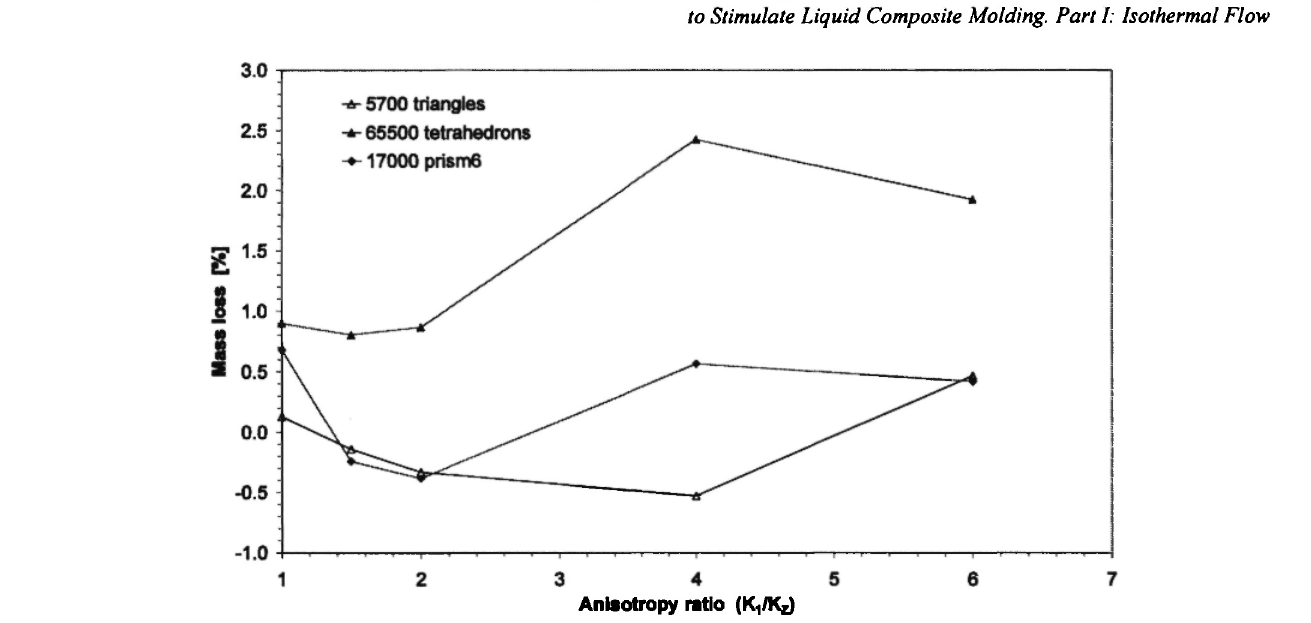
Fig. 14: Comparison of mass loss for simulations with triangles, tetrahedrons and prism6 elements. In all cases, the mass loss is less than 3%. The prism6 solution is systematically more conservative than tetrahedrons and close to the triangle solution.